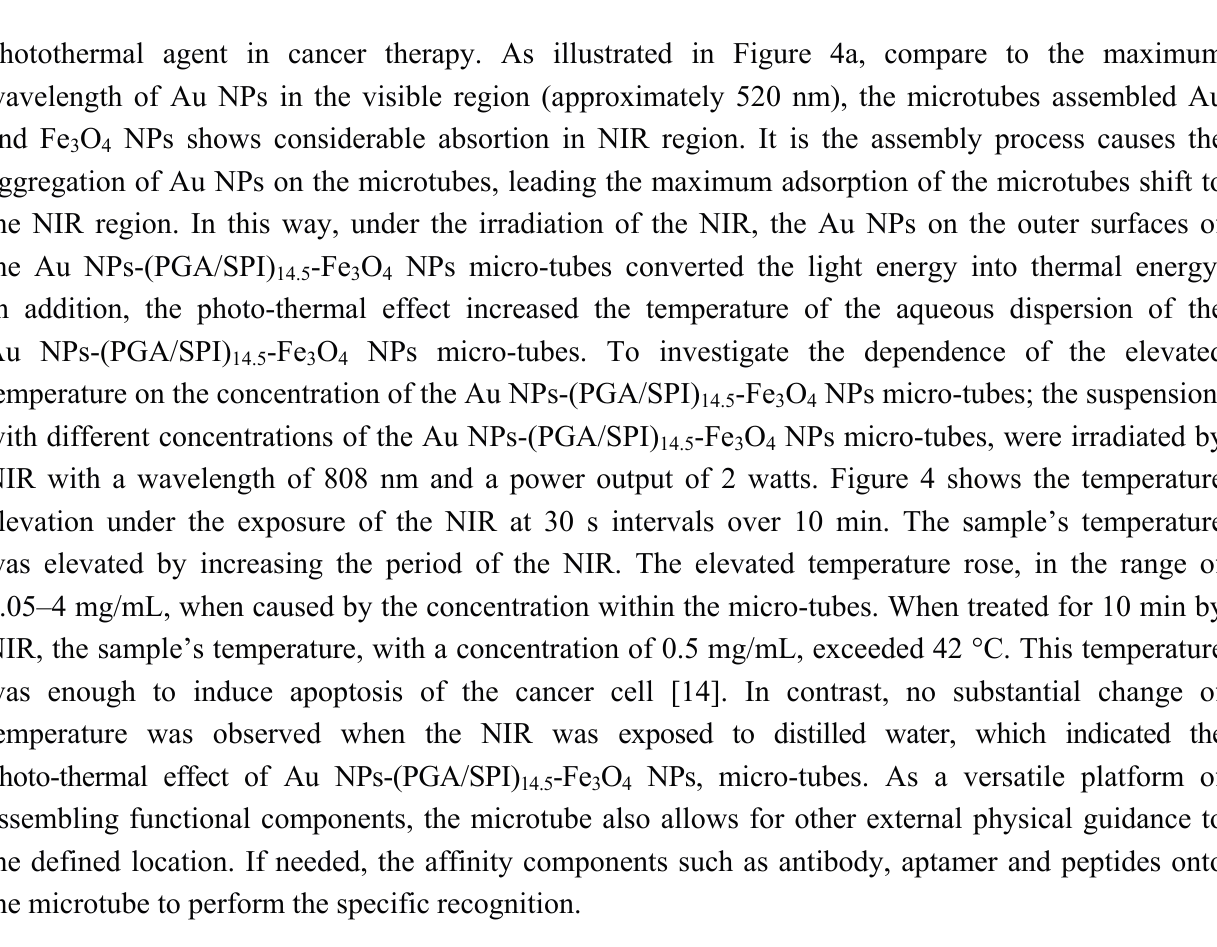
Figure 4. Heating effect of the microtube under the near infrared radiation (NIR) irradiation. ( a ) UV-vis spectrum of the bold microtube (black line), Au NPs (red line), and -Fe O NPs micro-tube (blue line); ( b ) The elevated temperature of Au NPs-(PGA/SPI) 14.5 3 4 suspension of the Au NPs-(PGA/SPI) -Fe O NPs micro-tubes with different concentration 14.5 3 4 (0.05, 0.1, 0.2, 0.5, 1.0, 2.0, 4.0 mg/mL) under the irradiation of NIR conducted every 30 s over 10